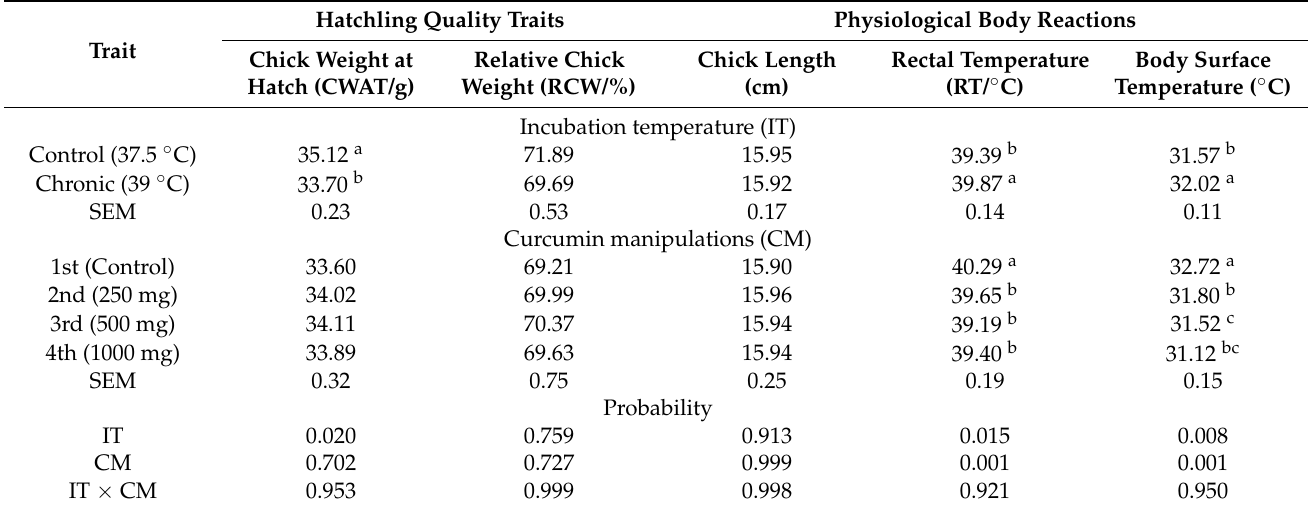
Table 2. Impact of incubation temperature, curcumin manipulations, and their interaction on hatchling quality traits (after 12 h from hatch), and physiological body reactions of newly-hatched chicks.